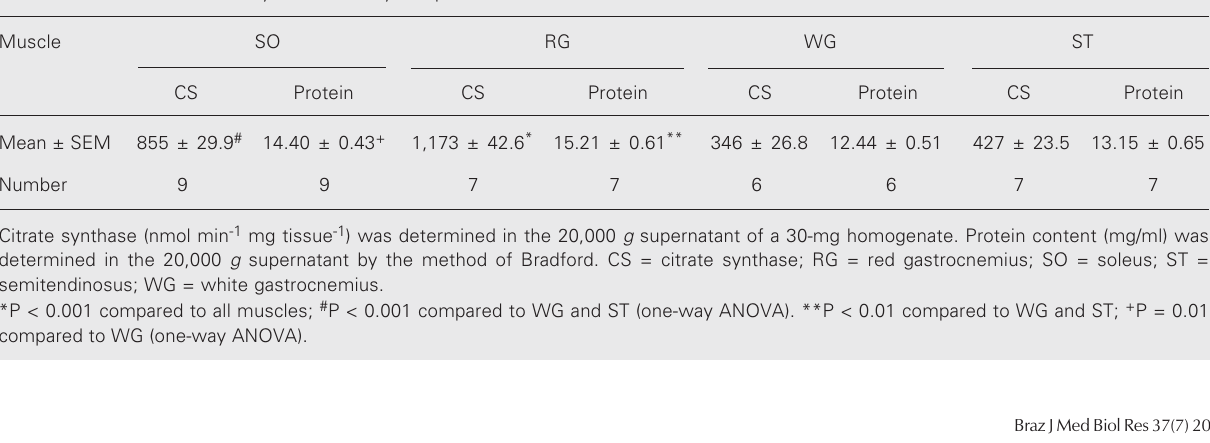
Table 2. Mitochondrial citrate synthase activity and protein content of different rat skeletal muscles. Muscle SO RG WG ST CS Protein CS Protein CS Protein CS Protein Mean ± SEM